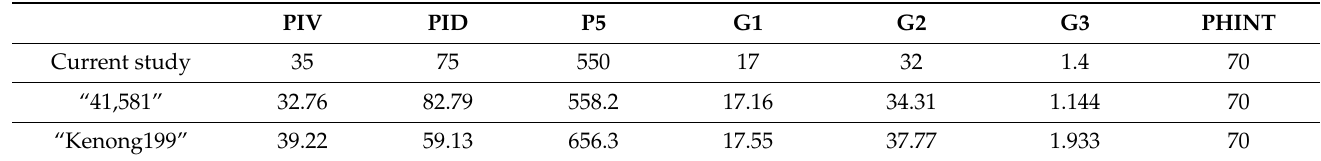
Table 6. Comparison of the current study vs.